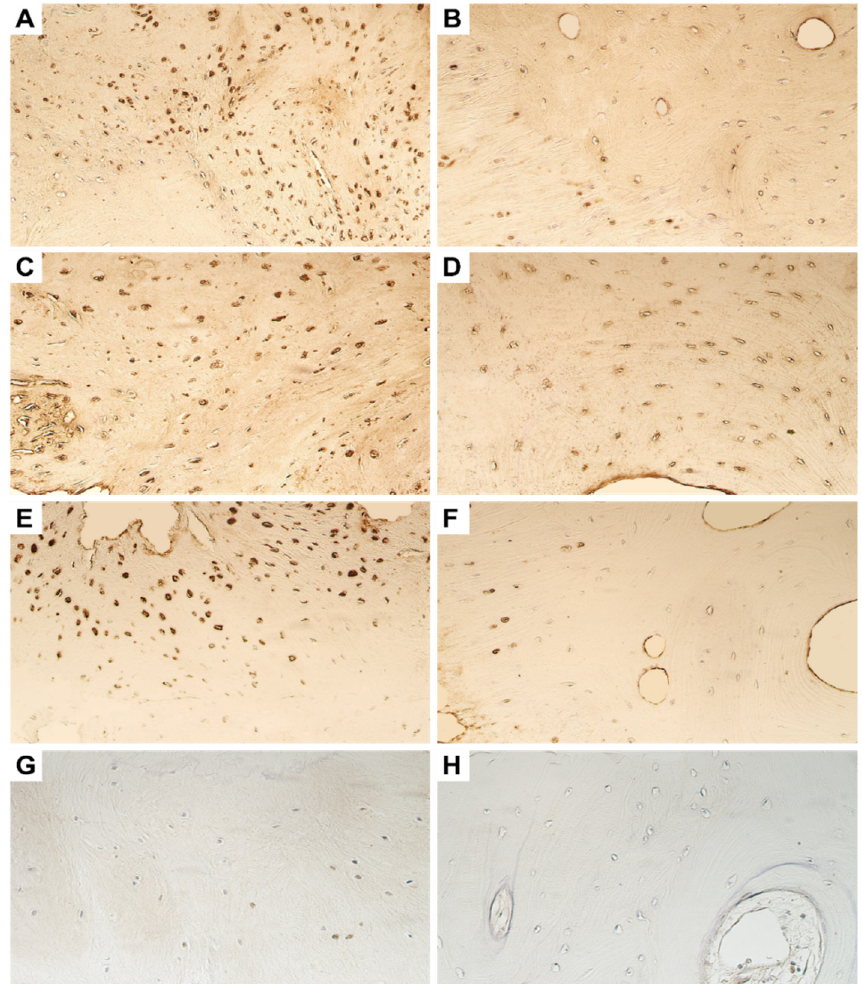
Figure 2. Microphotographs of the ankylotic bone and fibrous cartilage immunostained by MMP-2, -8, -9, and -13. ( A ) Numerous positive bone osteocytes for MMP-2 can be seen in the primary surgery tissue. ( B ) Note the presence of only few MMP-2-positive osteocytes and chondrocytes in the repeated surgery tissue. ( C ) Numerous MMP-8-positive osteocytes can be seen in the primary surgery tissue. ( D ) Numerous MMP-8 immunopositive osteocytes can also be seen in the repeated surgery tissue. ( E ) Moderate MMP-9-positive osteocytes with a patchy distribution can be seen in the primary surgery tissue. ( F ) In the repeated surgery tissue, only few MMP-9-positive osteocytes and chondrocytes can be visualized. ( G ) Scantly distributed MMP-13-positive osteocytes can be noted in the primary surgery tissue material. ( H ) There is complete absence of MMP-13-positive cells in the repeated surgery tissue. Original magnification, 250×.